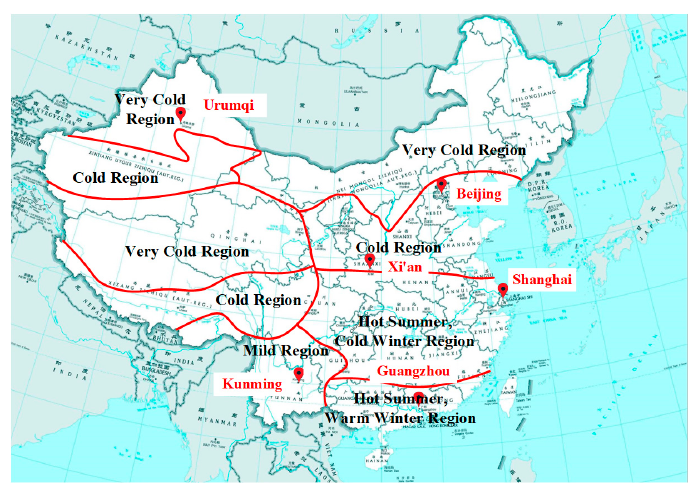
Figure 8. The climate distribution map of China.